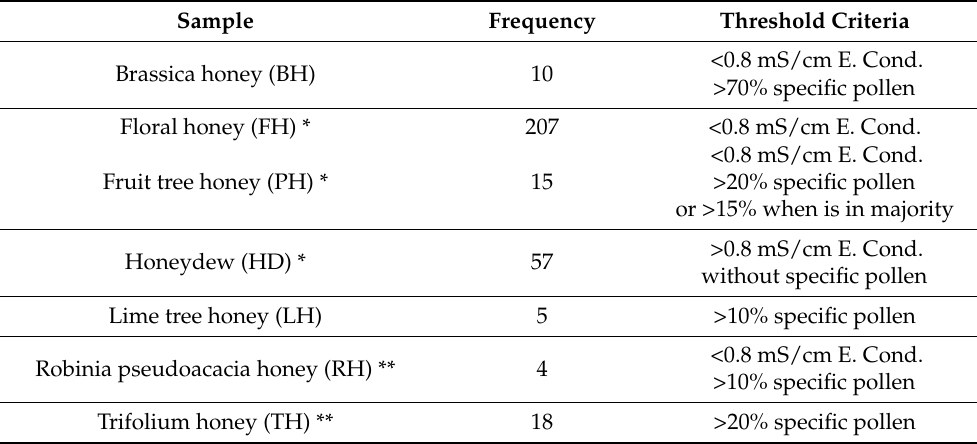
Table 1. Groups of classified honeys.